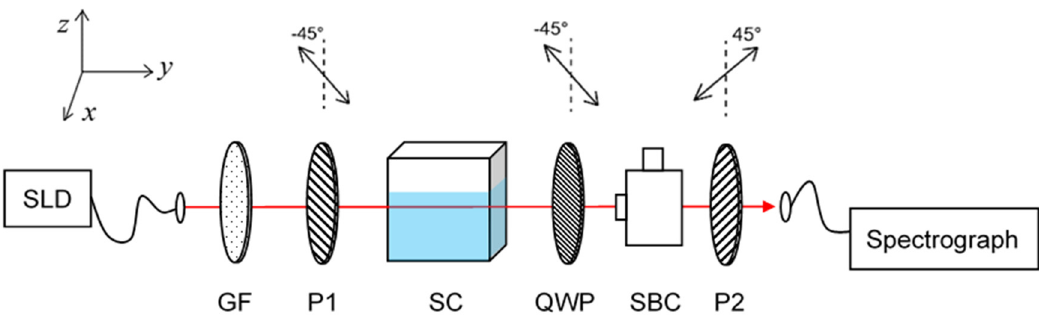
Figure 1. The experimental setup of optical weak measurement system. SLD, super luminescent diode. GF, Gaussian filter. P1 and P2 represent two same polarizer. SC, sample cell, especially for the holding of the liquid sample in detection. SBC, Soleil-Babinet compensator. QWP, quarter wave plate.